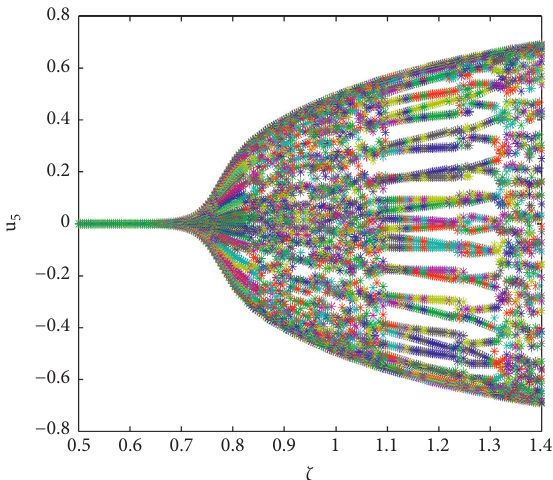
Figure 7: Bifurcation figure of neural network model (46): ζ - u −1.5−1−0.500.511.5 u 6